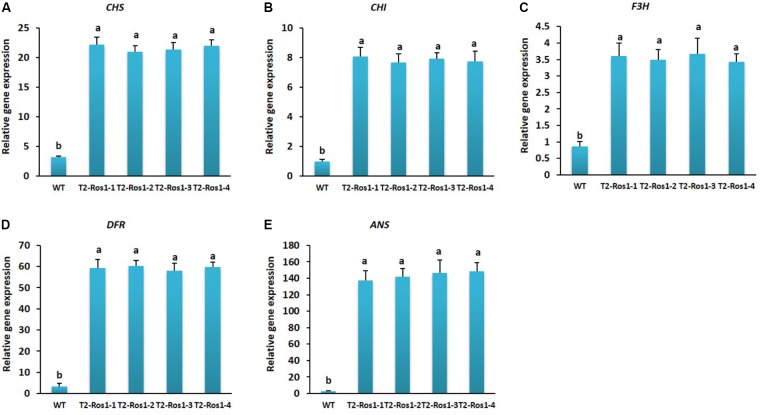
Transcriptional analysis of anthocyanin biosynthetic gene in leaves of WT and four independent T2-Ros1 lines (A–E). NtActin gene was used as reference gene to normalize the transcript levels of the genes. Error bars indicate the standard errors (SE) of means of three replicates. Means with different letters are significantly different (DMRT, p < 0.05).